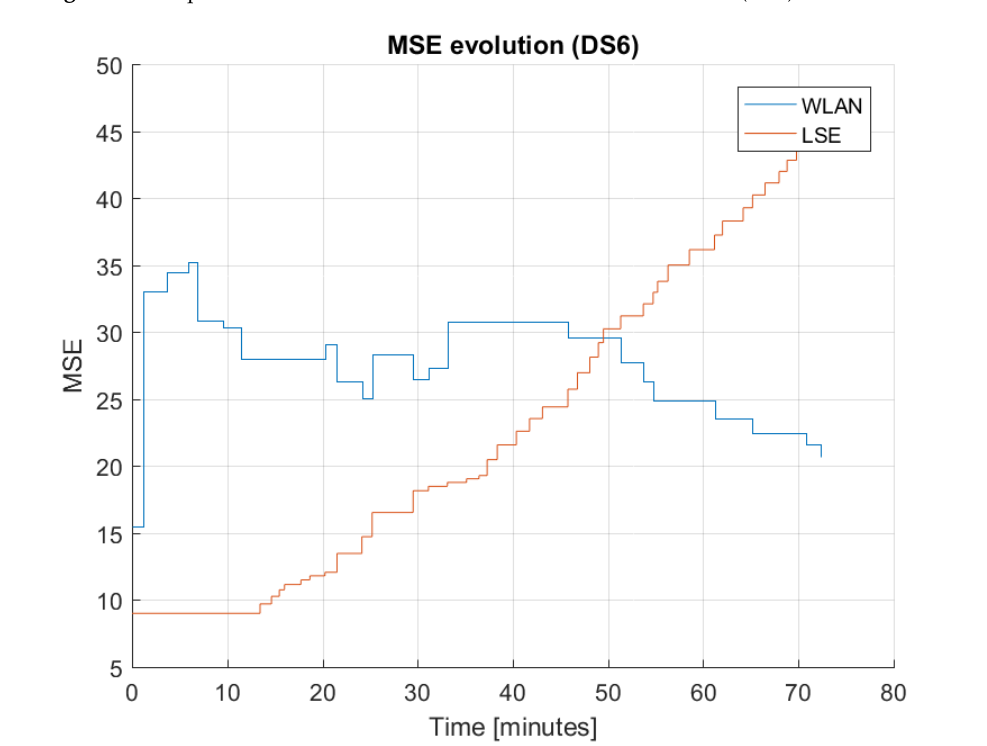
Figure 10. Evolution of MSE between GT and LSE or WLAN based on data set 6